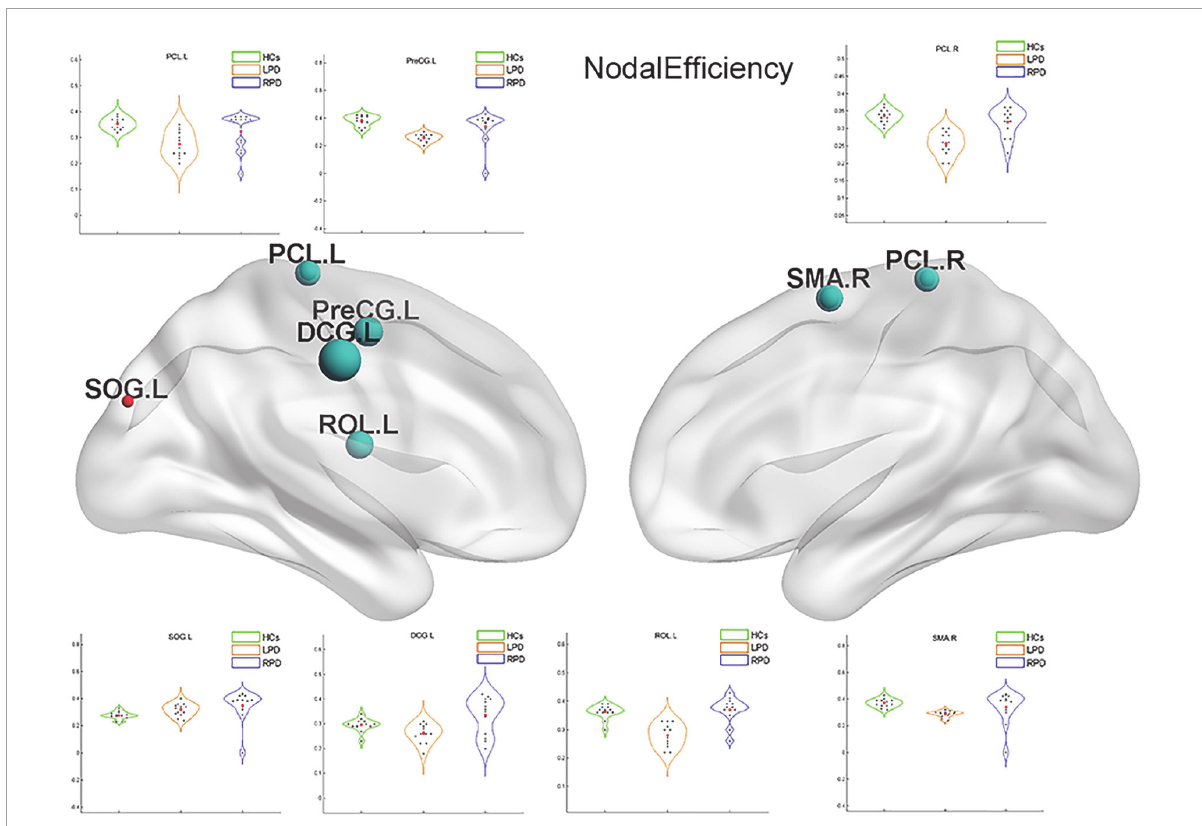
FIGURE4 Left-onset PD (LPD) patients showed decreased nodal efficiency (NE) in the left median cingulate and paracingulate gyri, left precentral gyrus, bilateral paracentral lobule, and right supplementary motor area as well as increased NE in the left superior occipital gyrus.